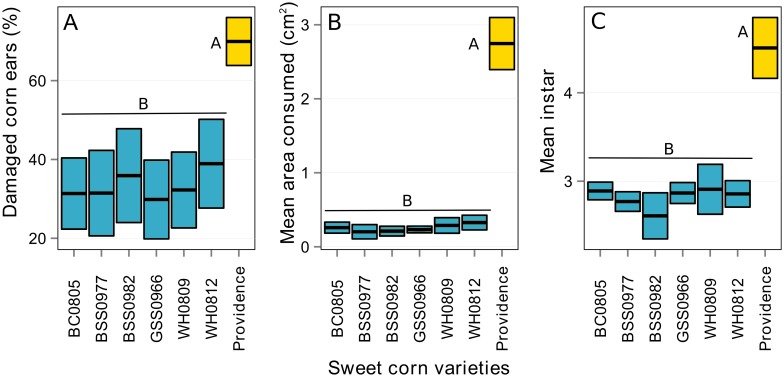
Results comparing control efficacy variables among Bt and non-Bt hybrid varieties in Maryland, USA in 2008.The mean damaged ears (A), kernel area consumed, (B), and instars of susceptible larvae (C) was broadly similar among the Cry1Ab expressing Bt hybrids (blue bars), and significantly different (Tukey’s HSD; α = 0.05; denoted by unique alphabets) from non-Bt control hybrids (yellow bar). Black lines represent the mean values and the height of bars above and below the black lines respectively indicate the upper and lower confidence levels (95% CI) estimated through LMMs.